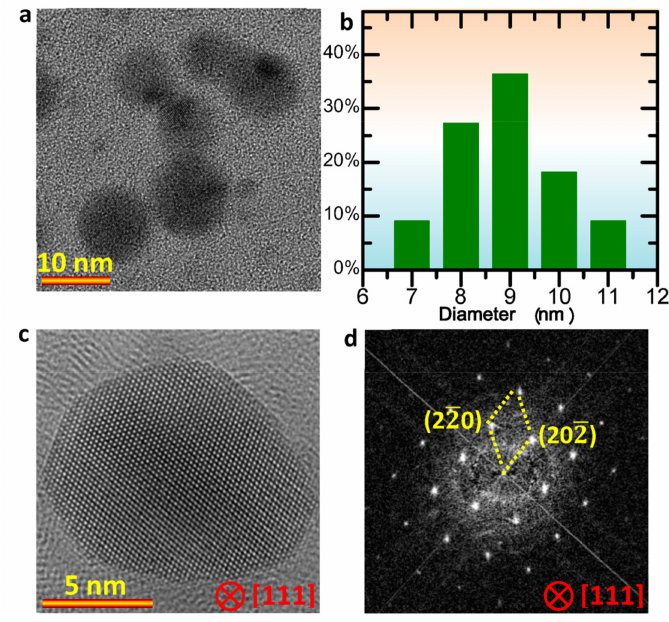
Figure 1. The morphology and size of Au NPs. ( a ) TEM image showing the morphology of Au NPs; ( b ) statistical analysis showing the size distribution of the highly dispersed Au NPs; ( c , d ) high-resolution TEM image and corresponding FFT pattern of a Au